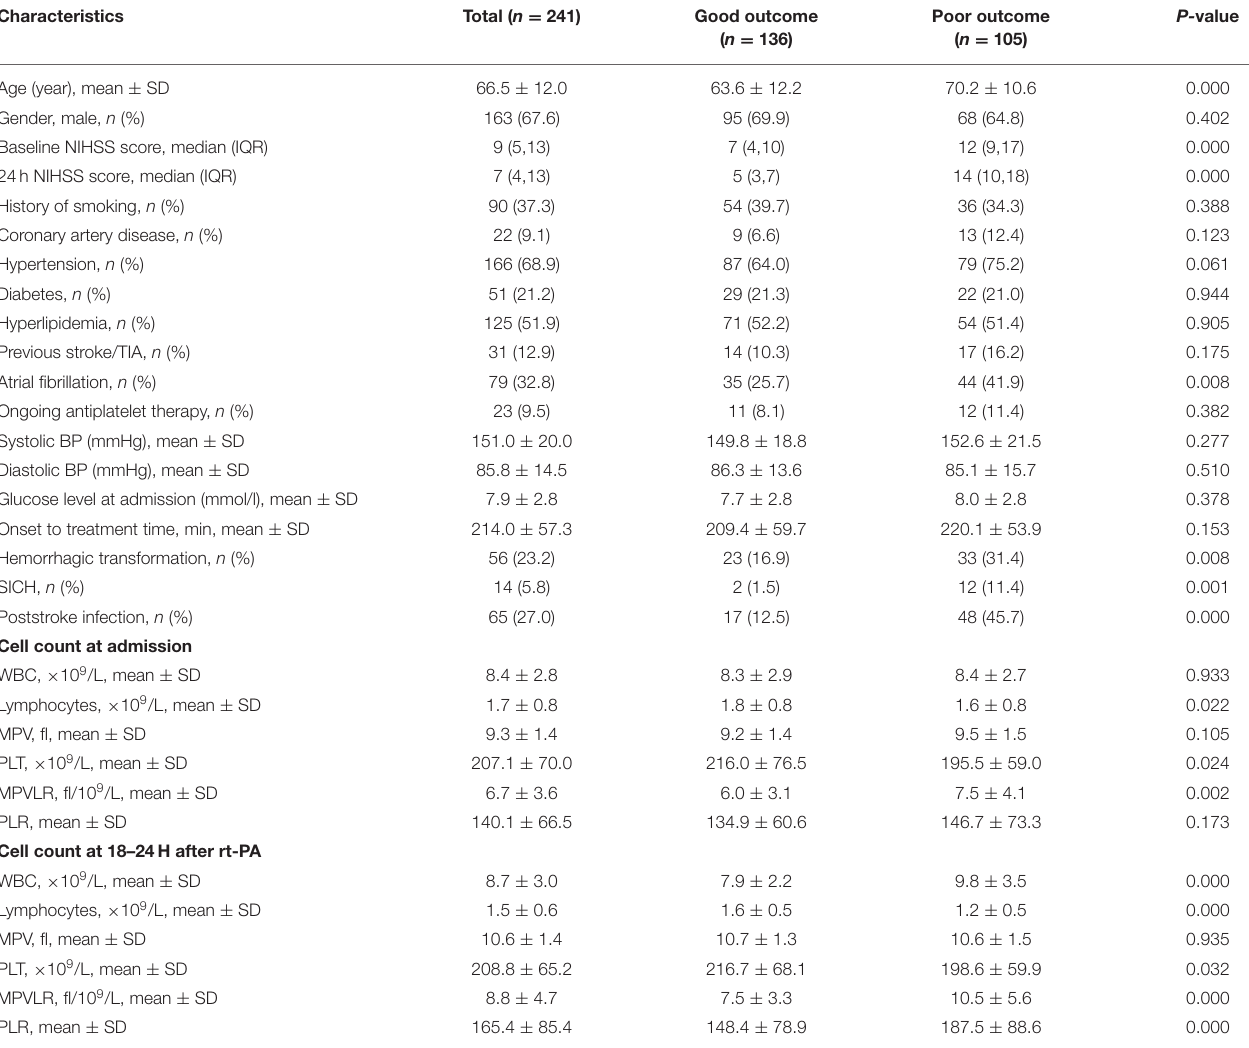
TABLE 1 | Comparison of the baseline characteristics between patients with poor and good functional outcomes.